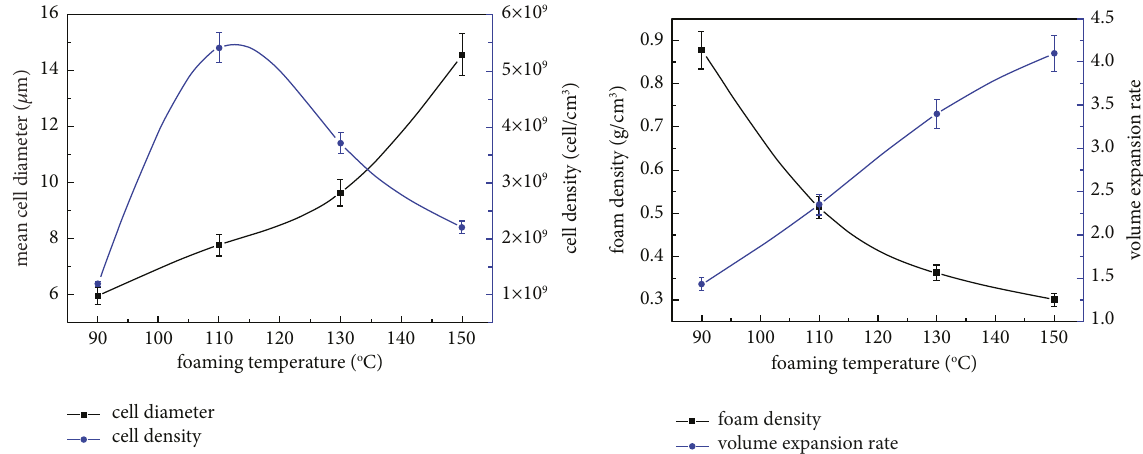
Figure 7: Effect of different foaming temperatures on foaming of composites (2h,